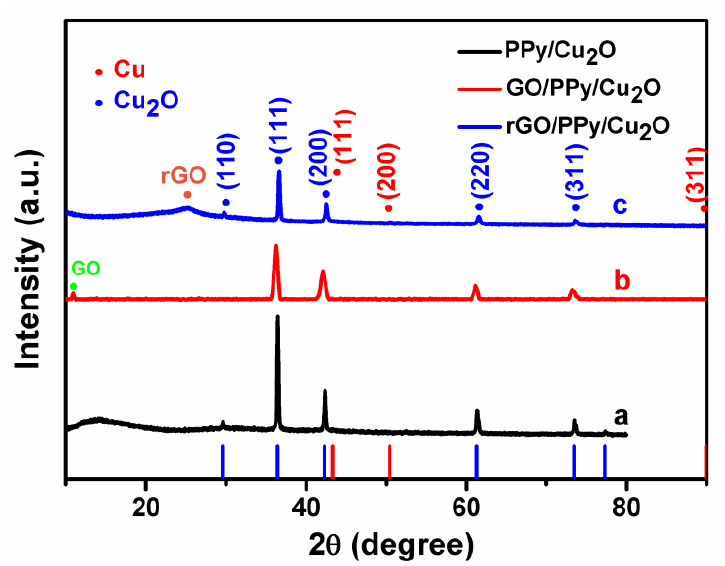
Figure 5. XRD patterns of (a) PPy-coated Cu 2 O, (b) GO/PPy/Cu 2 O nanocomposites and (c) rGO/PPy/Cu 2 O nanocomposites.